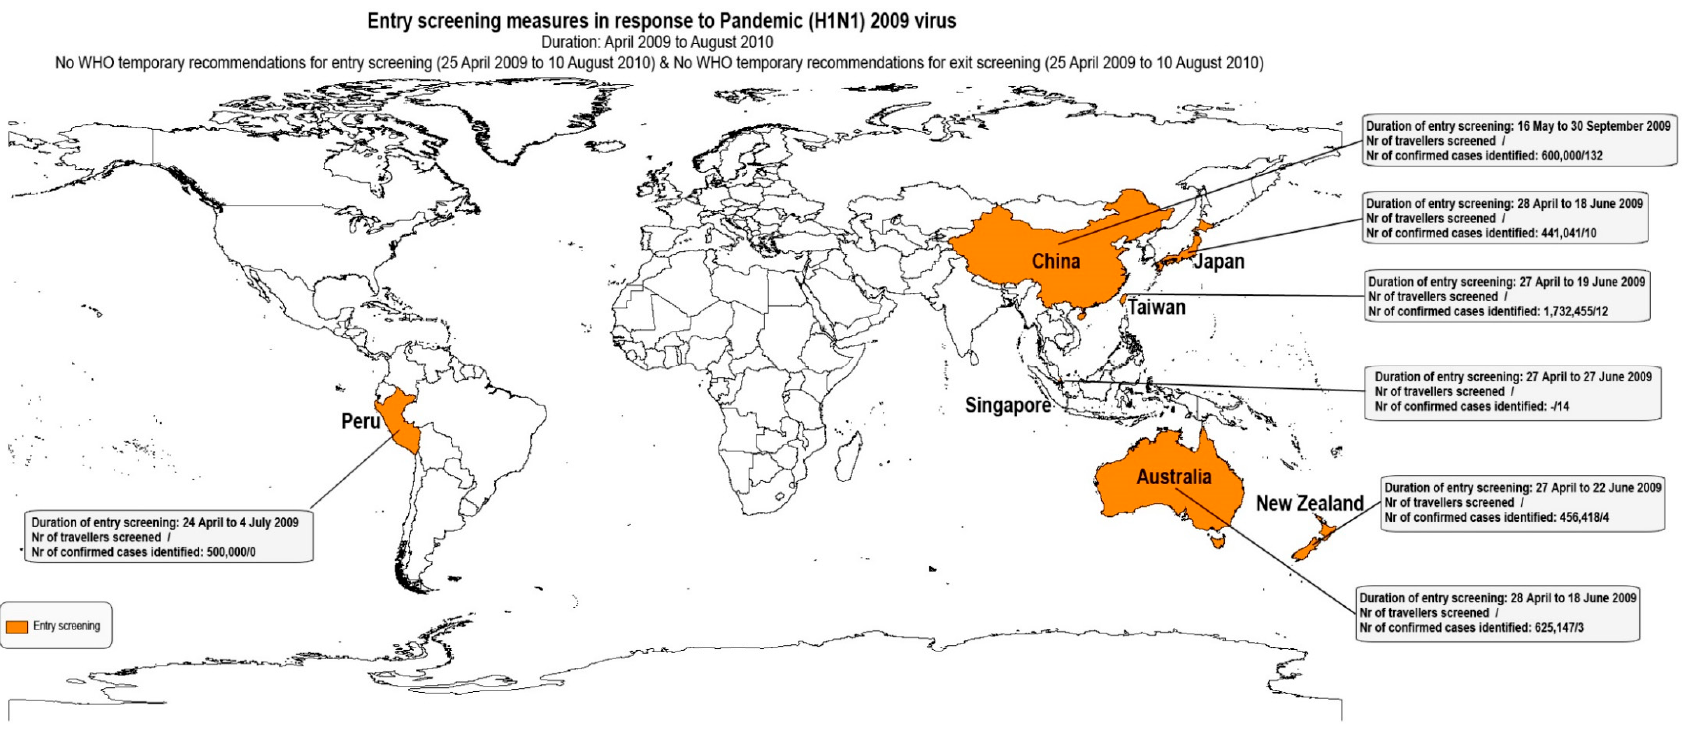
Figure 3. Published entry screening measures in response to Influenza Pandemic (H1N1) 2009 [20,21,24,32,33,36,40].